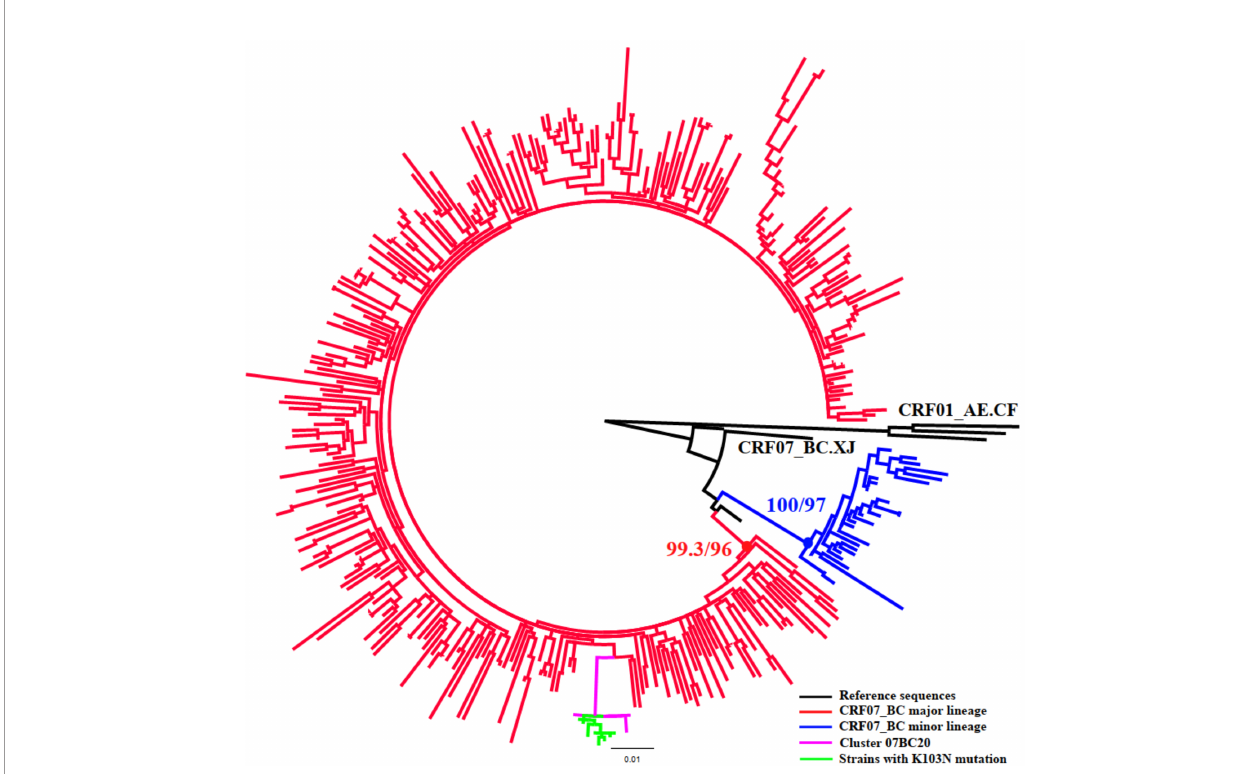
FIGURE 2 | Phylogenetic analysis of subtype CRF07_BC. The phylogenetic tree was constructed using the maximum-likelihood method based on the pol region (HXB2: 2,253 to 3,300nt). HIV-1 subtype CRF01_AE was chosen as an out-group in the CRF07_BC rooted tree. Only the sequences within the two lineages of CRF07_BC (88.8%, 349/393) were included in this ML tree. The molecular cluster (pink) including the strains with K103N (green) located in the main lineage of CRF07_BC